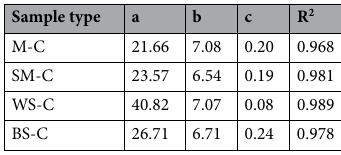
Table 2. Fitting